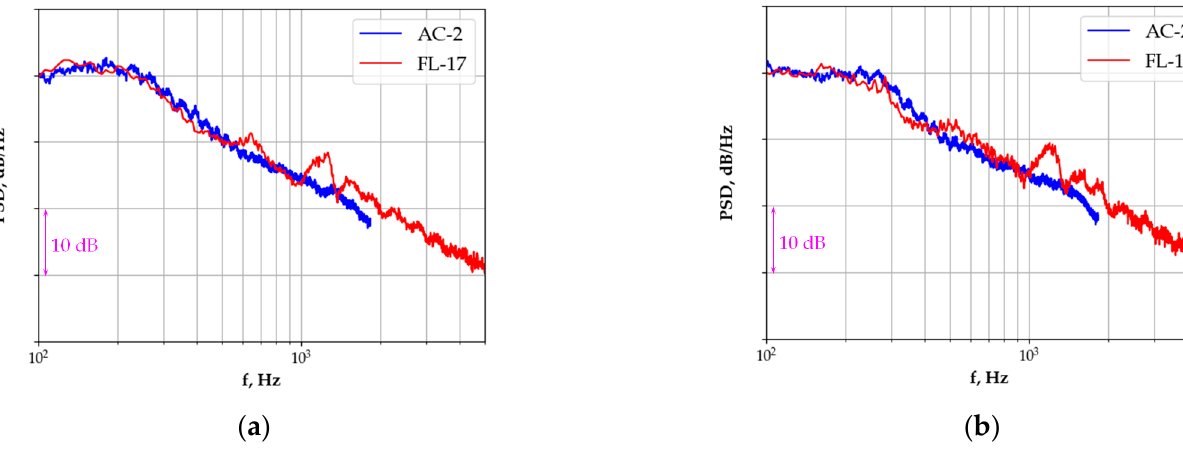
Figure 16. Comparison of the normalized spectra of the six-wheel landing gear model. Microphone is at ( θ , φ ) = (90°, 20°). Flow speed is 75 m s − 1 . The main leg is ( a ) high, ( b ) medium.